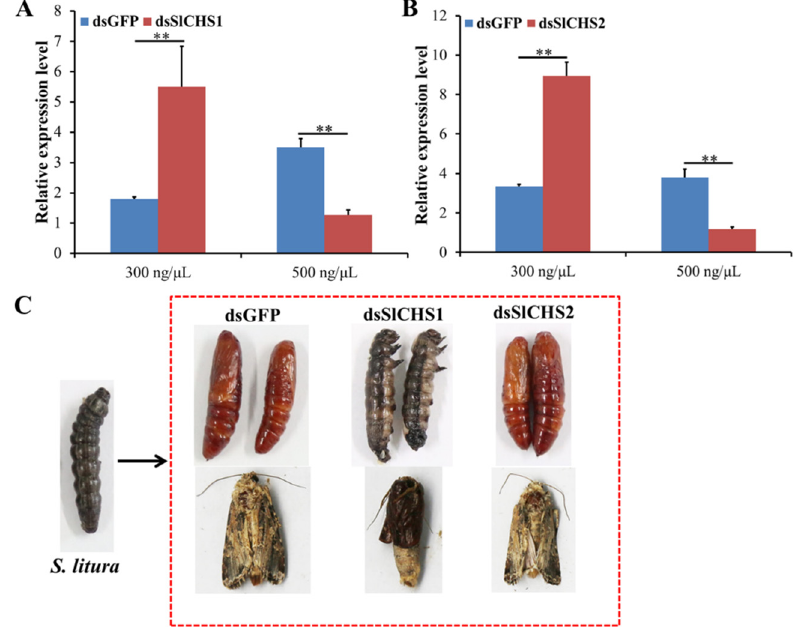
Figure 5. Effect on S. litura after RNA interference of SlCHS1 and SlCHS2 . ( A ) Relative expression levels of SlCHS1 when S. litura was treated with dsSlCHS1 and dsGFP at different concentrations. (B ) Relative expression levels of SlCHS2 when S. litura was treated with dsSlCHS2 and double-stranded dsGFP at different concentrations. The mean expression level is represented for three biological replicates. Relative expression levels were calculated using the 2 − ∆∆ Ct method. Statistical analysis was performed using SPSS software. All data were analyzed using ANOVA and Tukey’s test. Significant di ff erences are indicated by ** ( p < 0.01). ( C ) Representative phenotypes of S. litura at 24 h after dsGFP, dsSlCHS1 and dsSlCHS2